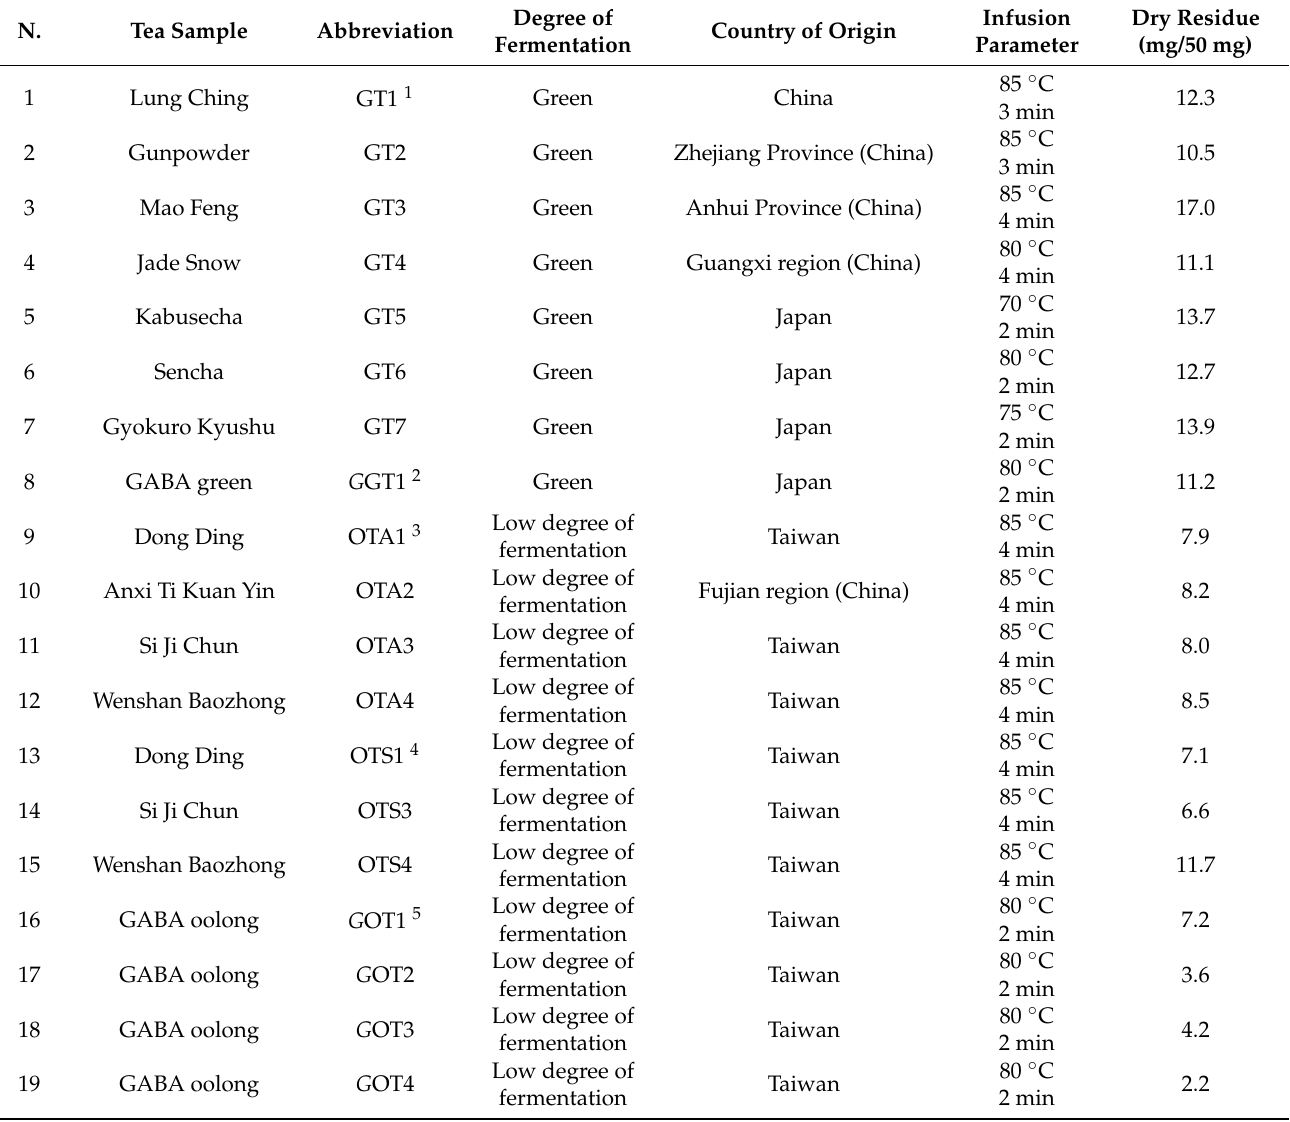
green tea characteristic polyphenolic compounds. Moreover, the GT7 sample was found to be similar to oolong teas being characterized by a low content of ARBMI, theanine, and caffeine. Although the literature data reported a significant effect of pedoclimatic conditions (including climate condition, soil) on teas’ chemical composition [23–25], in- dependently of the production season (autumn or spring), green teas were characterized by very high levels of caffeine, ARBMI, and theanine, which provided a great stimulating capacity, whereas oolong tea samples showed a higher level of sucrose. These results are in agreement with Lee et al., Le Gall et al., and Tarachiwin et al., by which caffeine, gallic acid, and theanine are believed to be possible quality markers of green tea, and thus their high contents are responsible for the high quality of the tea [26–28]. Table 1. List of selected teas, their abbreviations, the degree of fermentation, the origin, the infusion conditions as suggested by the supplier, and the dry residue obtained after freeze drying.